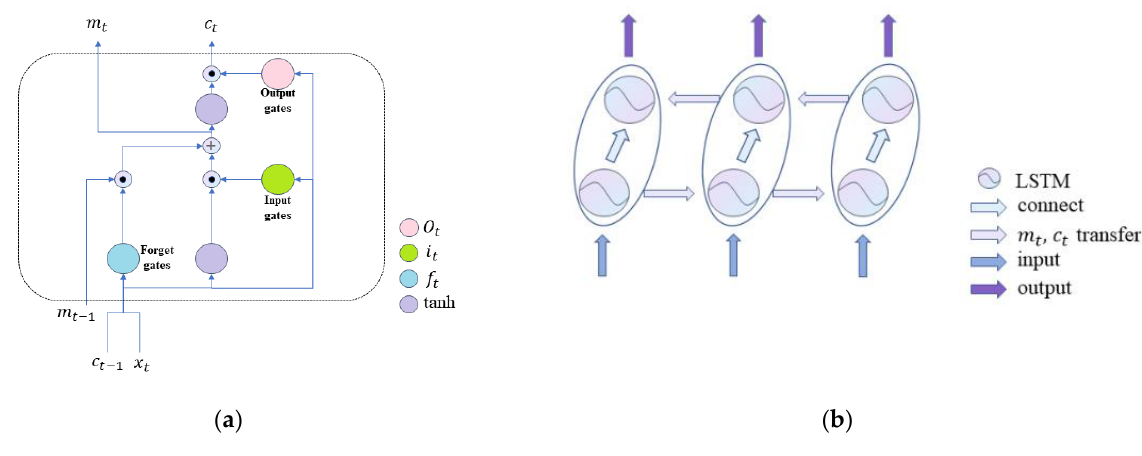
Figure 3. Structure of ( a ) LSTM and ( b ) Bi-LSTM.